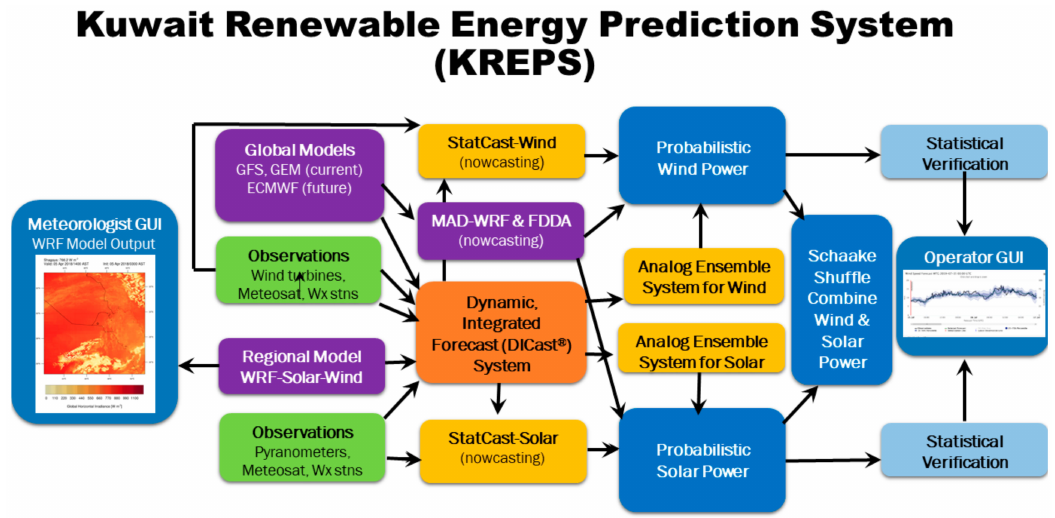
Figure 3. Diagram of components of KREPS. AI-based forecasting components are colored orange and